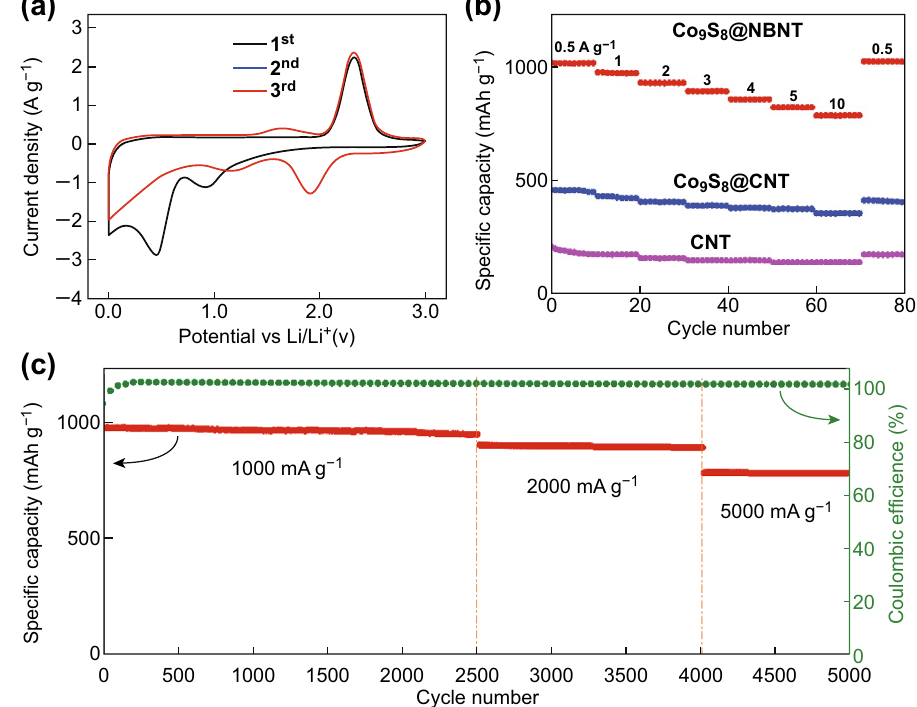
Fig. 3 a CV curves of the LIBs with Co 9 S 8 @NBNT. b Rate performance at different current densities of Co 9 S 8 @NBNT, Co 9 S 8 @CNT, and CNT. c Long‑term cycling performances of the Co 9 S 8 @NBNT anode at different current densities of 1000, 2000, and 5000 mA g